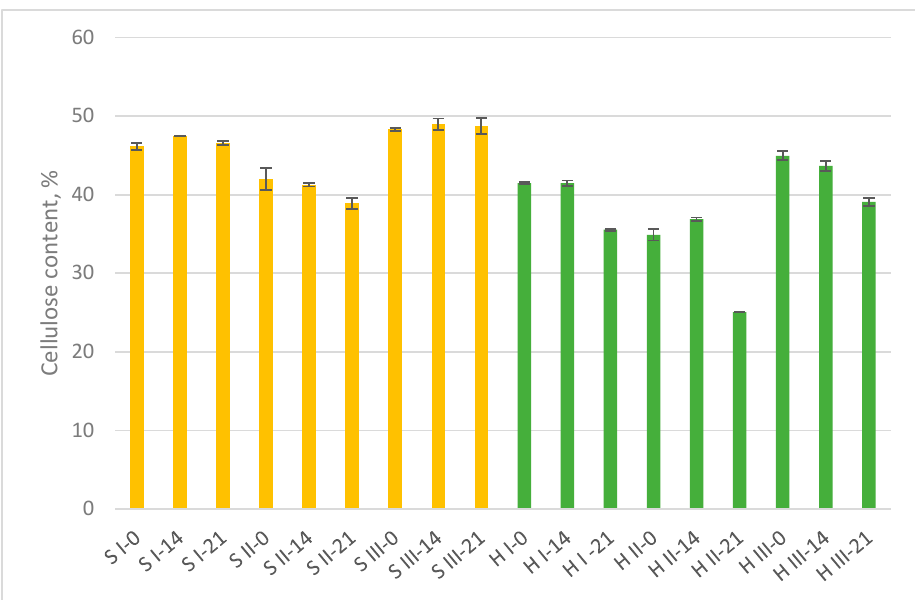
Figure 1. Cellulose content at three mycelium biocomposites’ development stages: start point (0 days), 14 days, and 21 days (final sample). S = sawdust; H = hemp; I, II, III = variants.